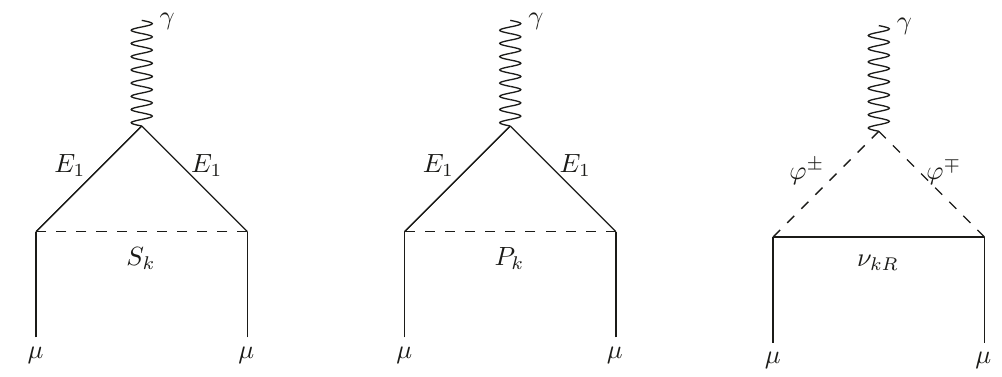
Figure 6 . Feynman-loop diagrams contributing to the muon anomalous magnetic moment. Here k = 1 , 2